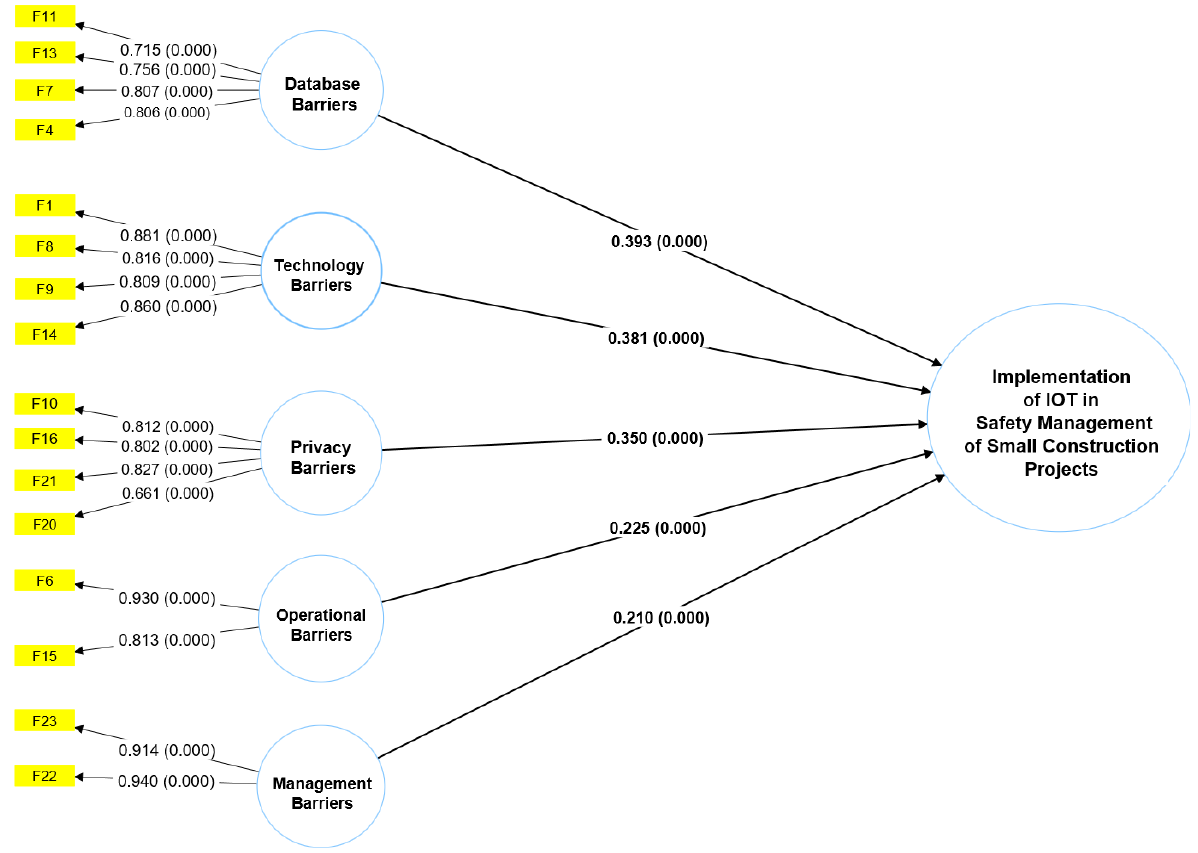
Figure 8. Path analysis of structural model.